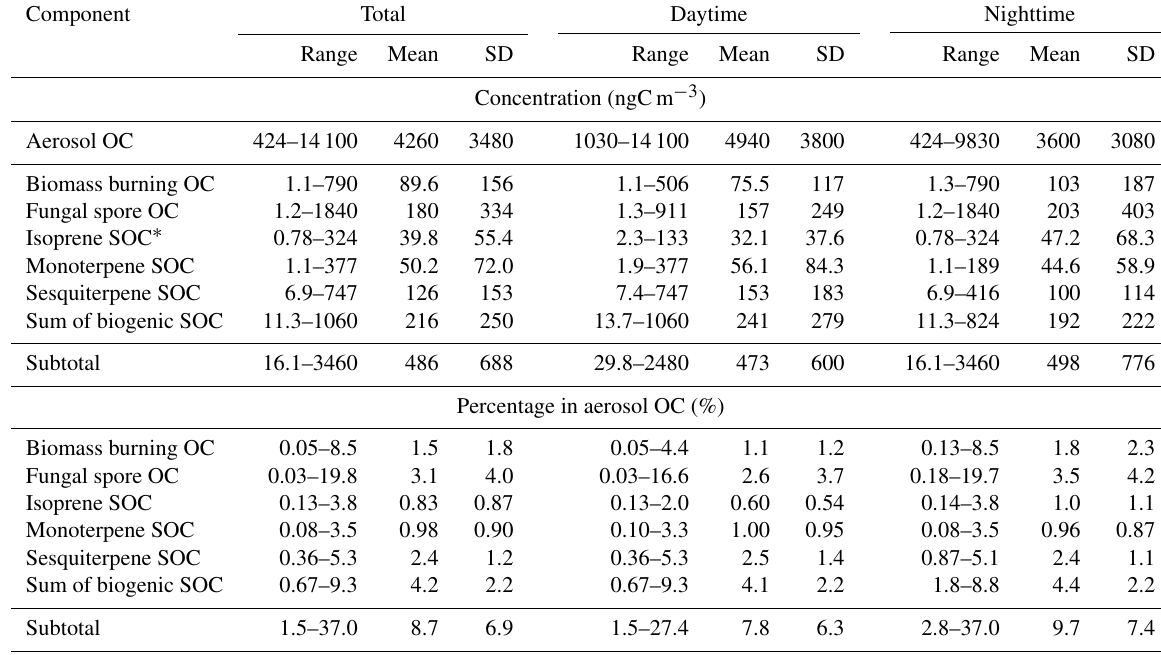
Table 2. Concentrations of organic carbon (OC) (ngCm − 3 ) from biogenic primary emission (biomass burning OC and fungal spore OC) and biogenic SOC and their contributions to aerosol OC (%) in marine aerosols over the East China